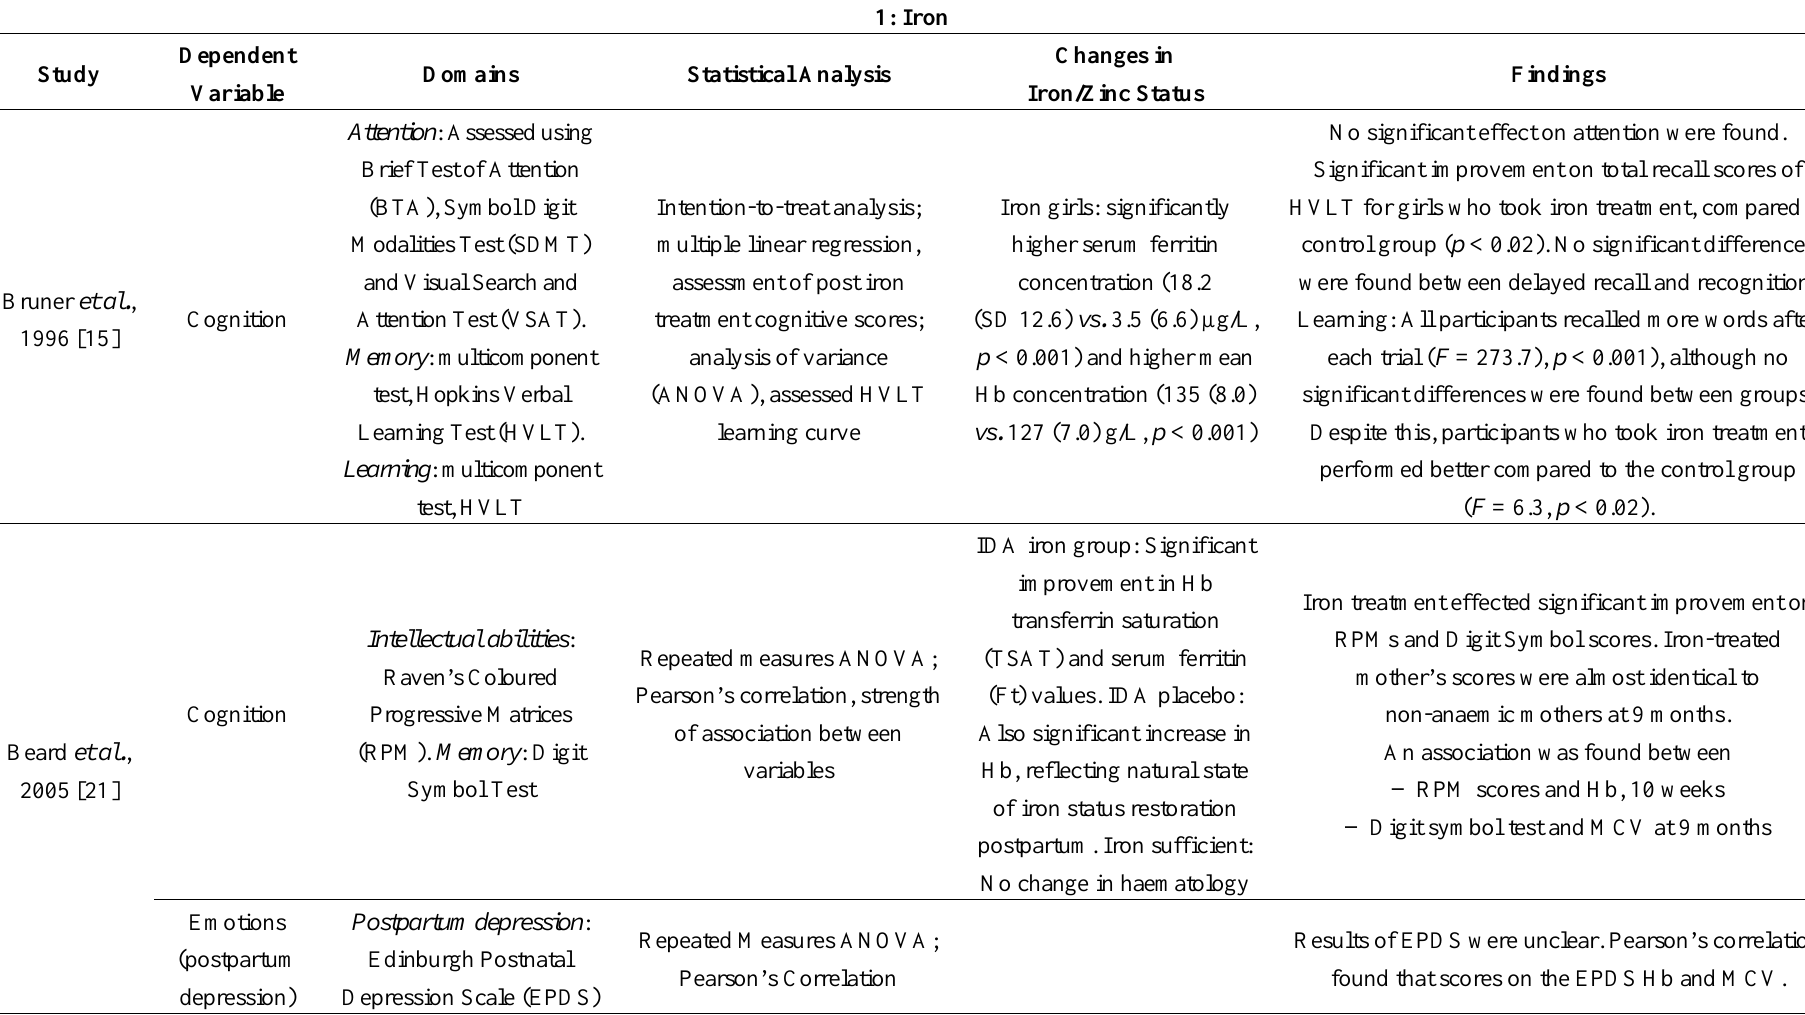
Table 3. Summary of relevant results. HVLT, Hopkins Verbal Learning Test; MCV, mean corpuscular